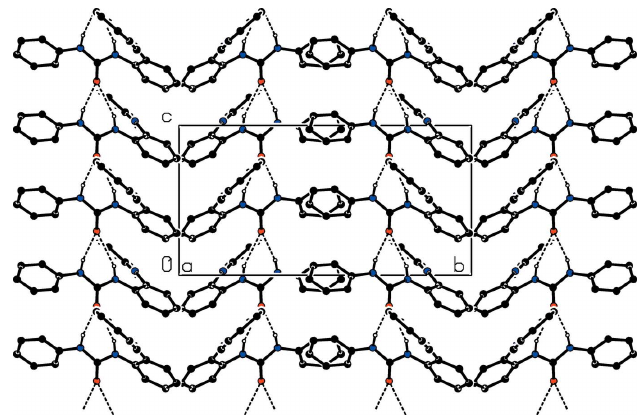
Figure 2 A view of the N—H (cid:3)(cid:3)(cid:3) O hydrogen bonding (dashed lines) along the a axis in the crystal of the title compound.